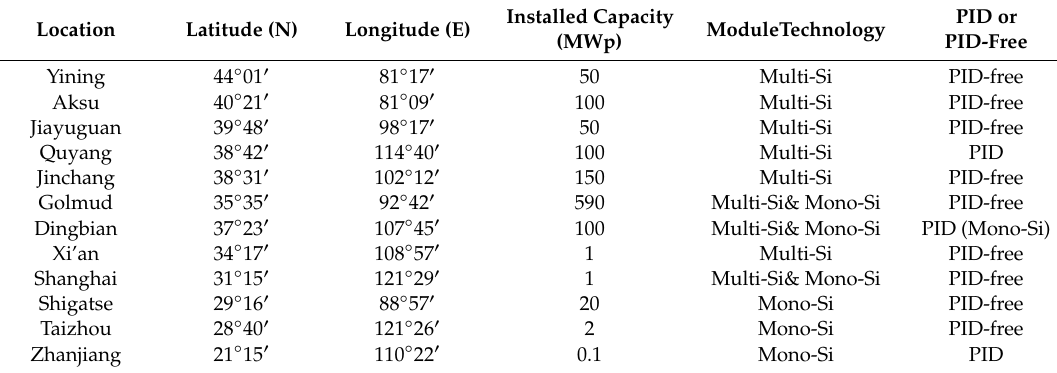
Table 1. Summary of the studied photovoltaic power plants.